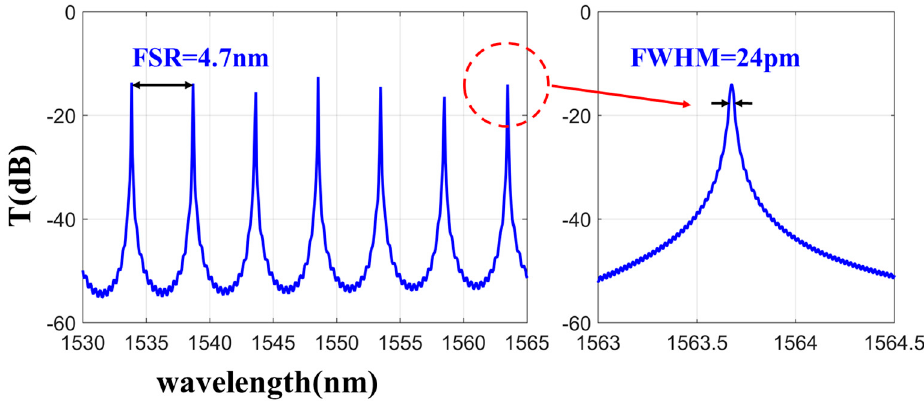
Figure 3. The simulated transmission spectra of rings at the drop from 1530 nm to 1565 nm.